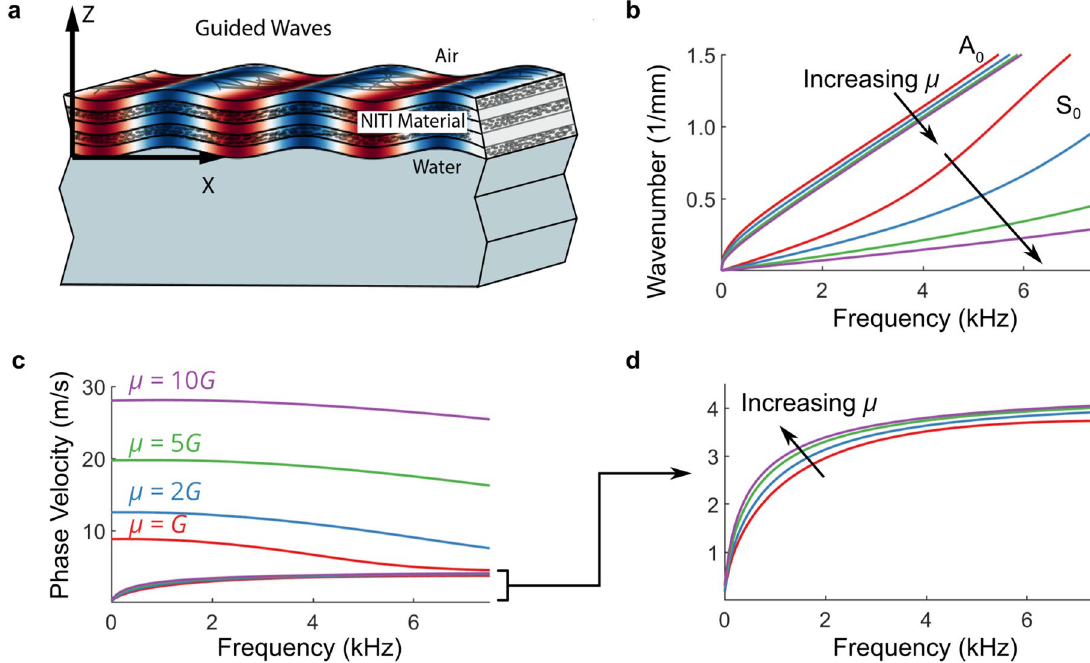
Figure 2. Analytical solutions for guided wave behavior in a bounded NITI layer. ( a ) Propagation of harmonic guided waves in cornea tissue, modeled as a NITI material layer bounded above by air and below by water. Dispersion relations for propagating guided modes are derived from partial wave solutions to the elastic wave equations satisfying corneal boundary conditions in Supplementary Note 4. ( b ) The effect of increasing anisotropy on fundamental (zero order) A 0 and S 0 modes ( G = 20 kPa, h = 0.55 mm, varying μ) presented in wavenumber-frequency space. The behavior of the A 0 mode is primarily governed by G , and the S 0 mode by μ. ( c ) The same dispersion curves in phase velocity versus frequency representation. ( d ) Zoomed view of the A 0 mode in phase velocity versus frequency representation—the high-frequency asymptote of the A 0 mode depends primarily on G , with its low-frequency rate of change governed by